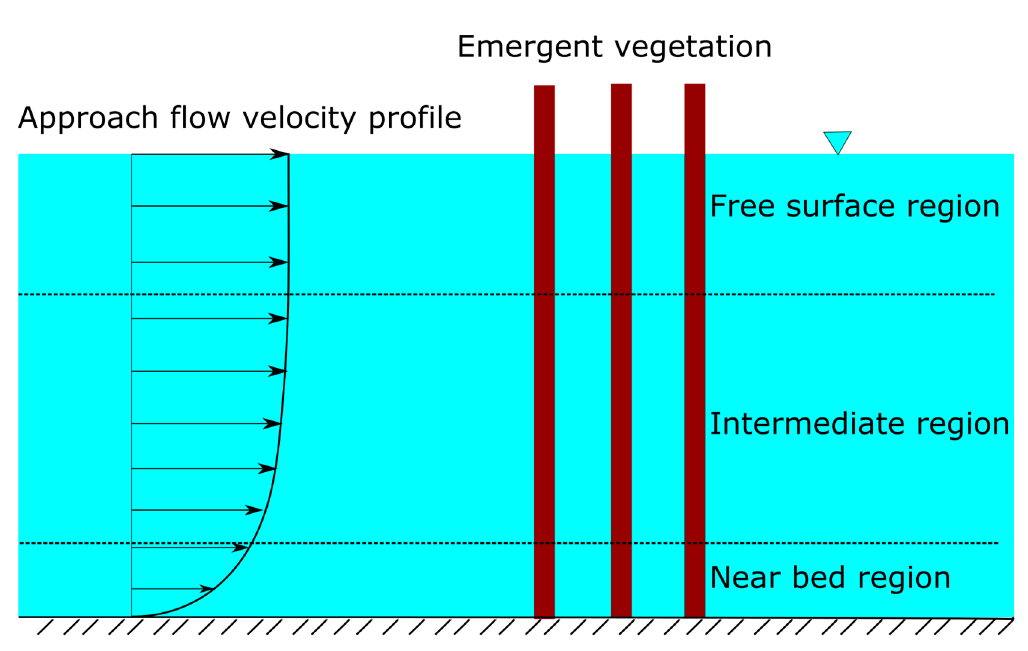
Figure 3. Vertical structure of flow in emergent vegetation.